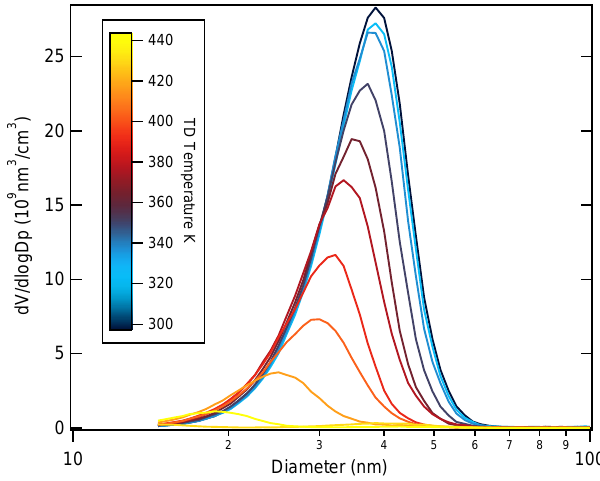
Figure 1. An example of the particle volume-weighted size dis- tributions observed as a function of TD temperature from one ex- periment. The temperatures range from room temperature (296K, light blue) to 453K (purple). This experiment had a bypass C OA = 9µgm − 3 and d p,V,bypass =